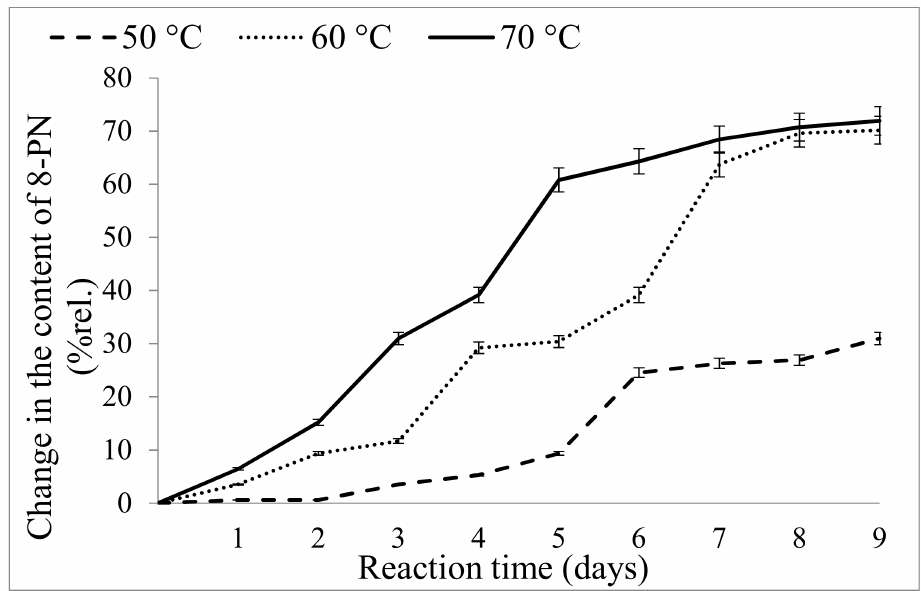
Figure 2. Isomerization of desmethylxanthohumol to 8-prenylnaringenin in the spent hops at different temperatures.